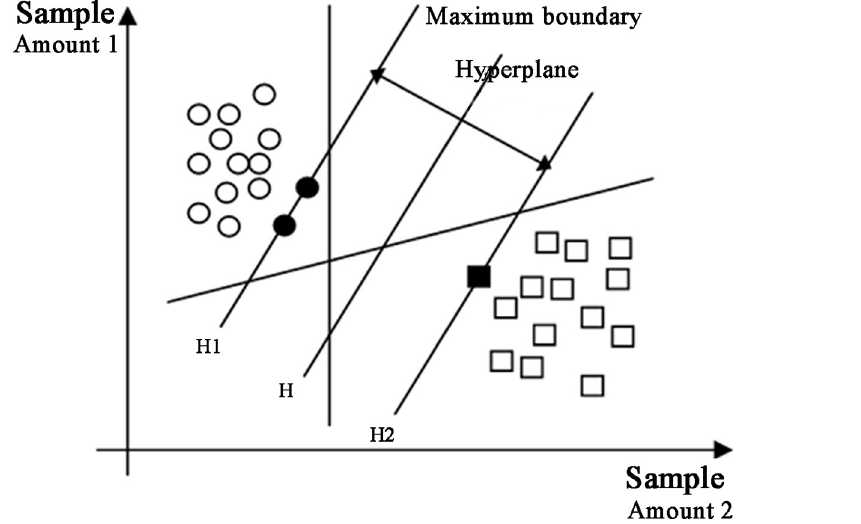
Fig 1. The optimal classification